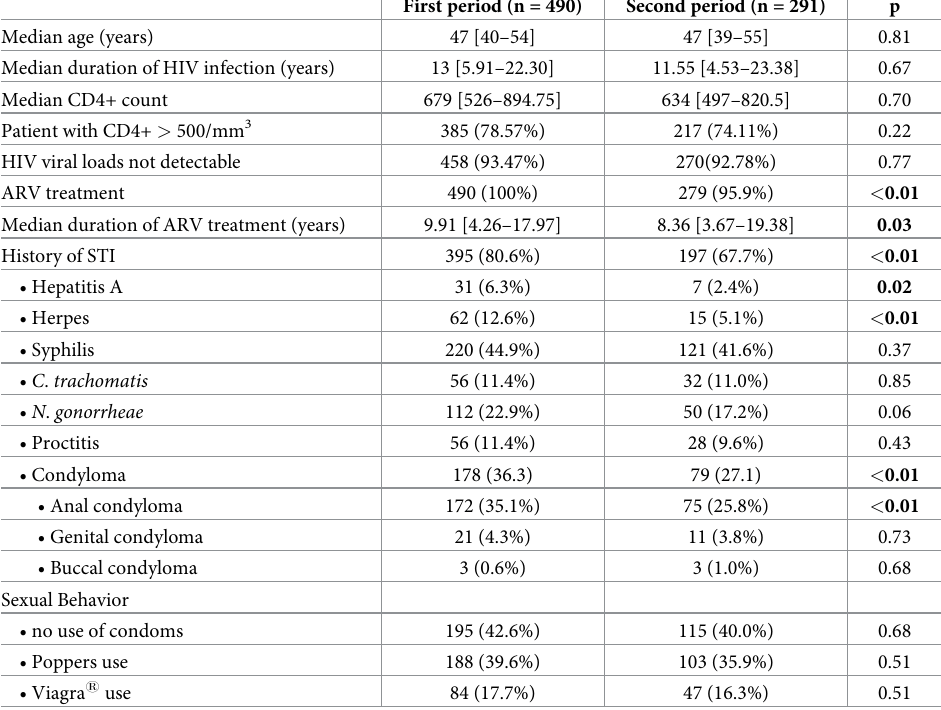
Table 2. Characteristics of patients, and history of reported